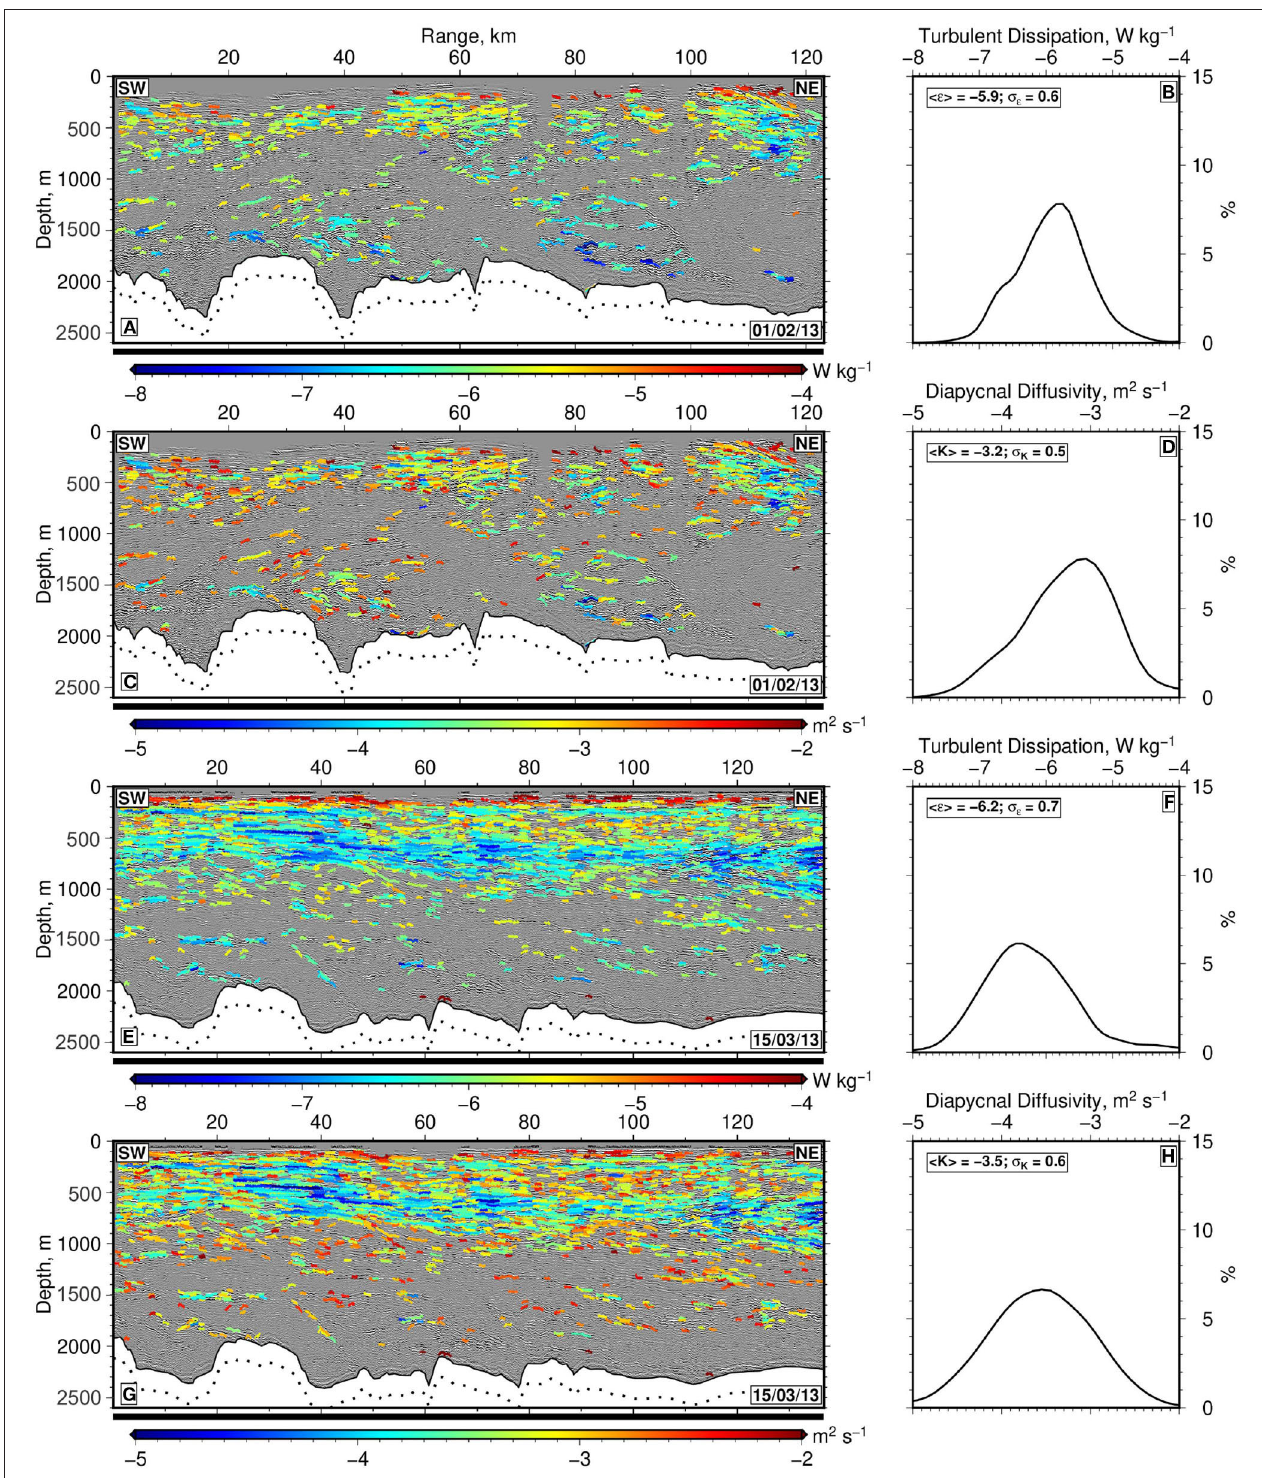
FIGURE 8 | (A) Section A of seismic reflection survey overlain with spatial distribution of turbulent dissipation rate, log 10 ε , calculated using spectral analysis of tracked reflectivity. Colored wiggly lines = 1,841 auto-tracked reflections where color indicates value of log 10 ε according to scale bar at base of (E) . (B) Histogram showing spatially averaged distribution of log 10 ε for (A) calculated using bin width of 0.1 and Gaussian filter length of 1. Numbers = weighted mean, <ε> , and standard deviation, σ ε , of values from Section A. (C) Same overlain with spatial distribution of diapycnal diffusivity, log 10 K . Colored wiggly lines = individual auto-tracked reflections where color indicates value of log 10 K according to scale bar at base of (E) . Note that global mean log 10 K is –5 (e.g., Waterhouse et al., 2014) and that uncertainty of calculated log 10 K is 0.4. (D) Histogram showing spatially averaged distribution of K . (E–H) Same for Section C with 2,310 tracked reflections.